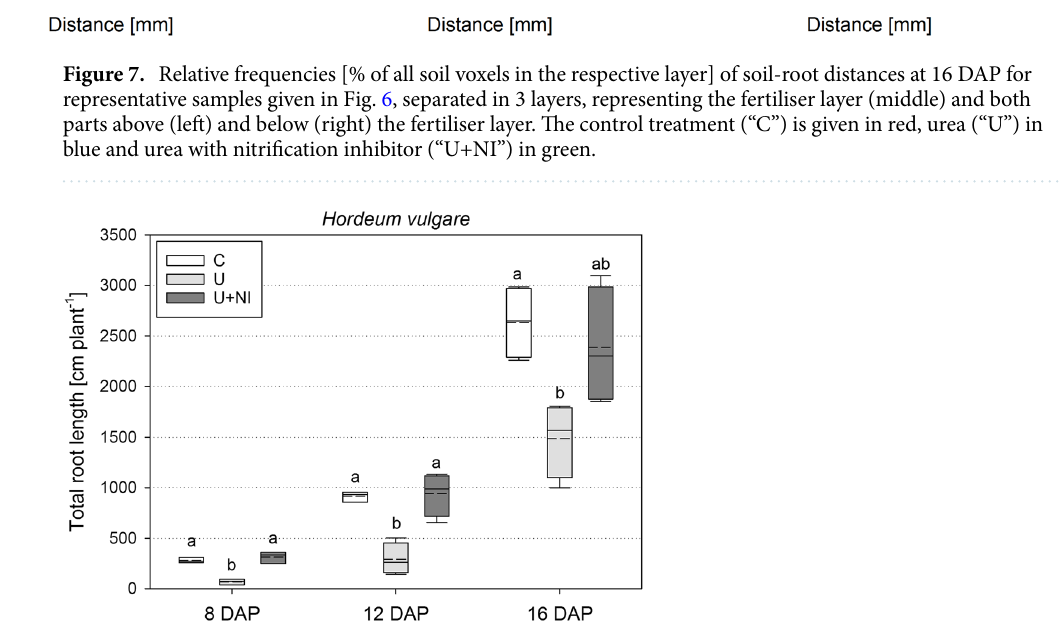
Figure 8. Total root length of Hordeum vulgare plants for the treatments control (“C”), urea (“U”) and urea with nitrification inhibitor (“U+NI”). Significant differences ( p < 0.05) are indicated by different letters; dashed lines in the boxplots represent mean values while solid lines represent the